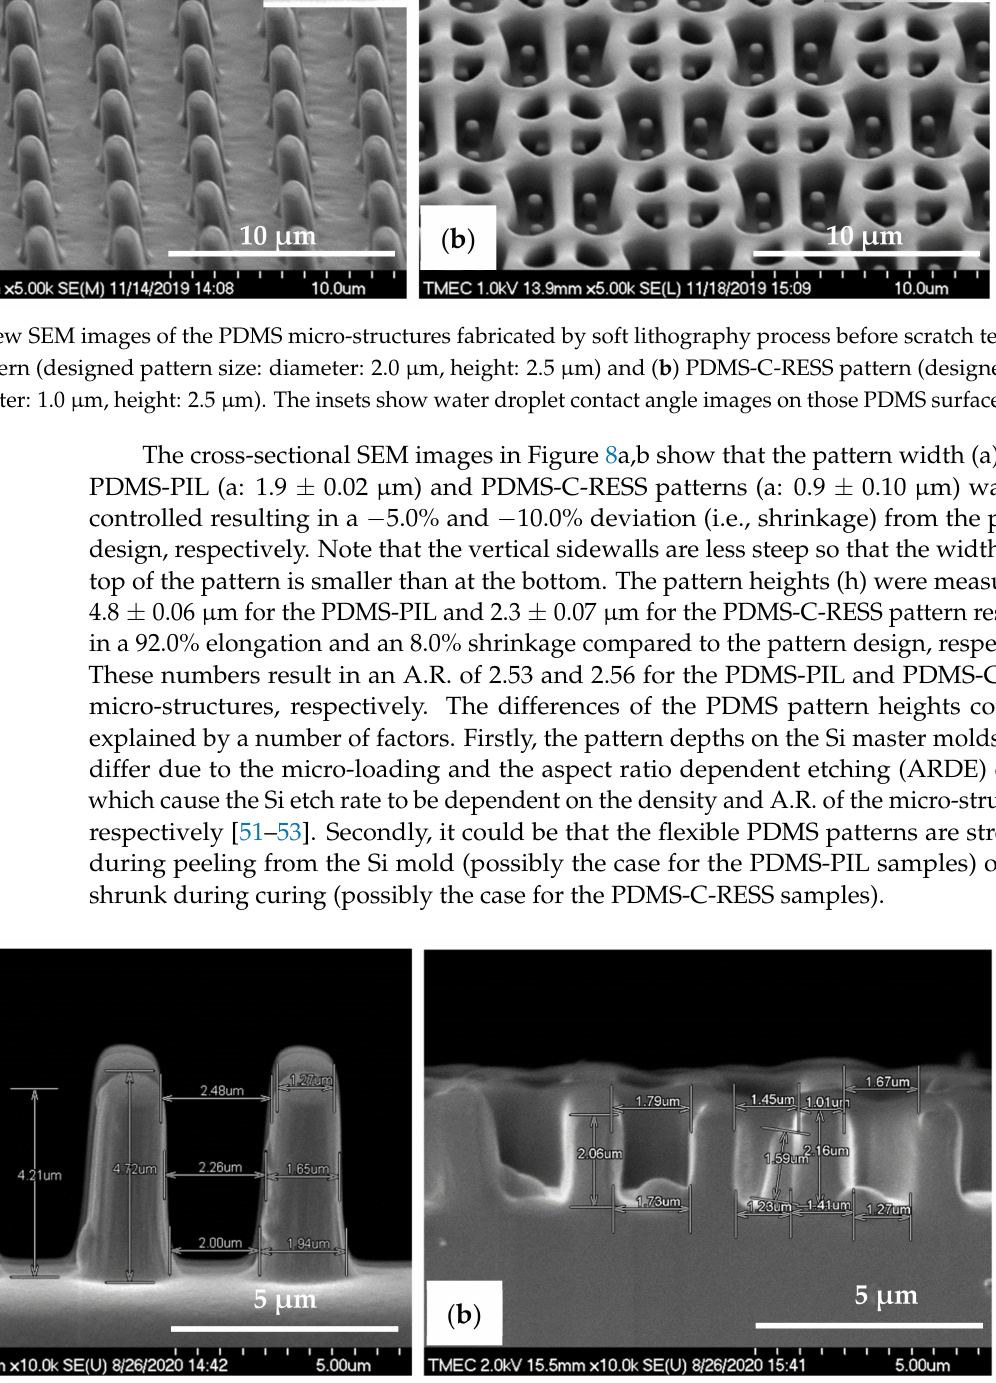
Figure 8. Cross-sectional view SEM images with corresponding measured dimensions of the PDMS micro-structures fabricated by soft lithography process before scratch test. ( a ) PDMS-PIL pattern (designed pattern size: diameter: 2.0 µ m, height: 2.5 µ m) and ( b ) PDMS-C-RESS pattern (designed pattern size: diameter: 1.0 µ m, height: 2.5 µ